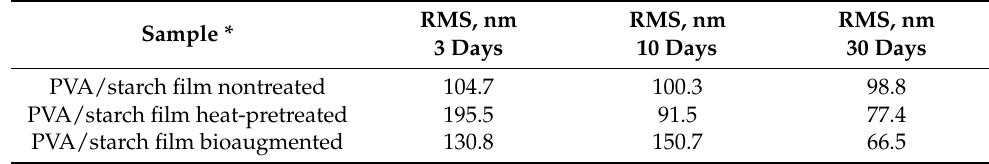
Table 5. AFM analysis results: RMS values of degraded films.